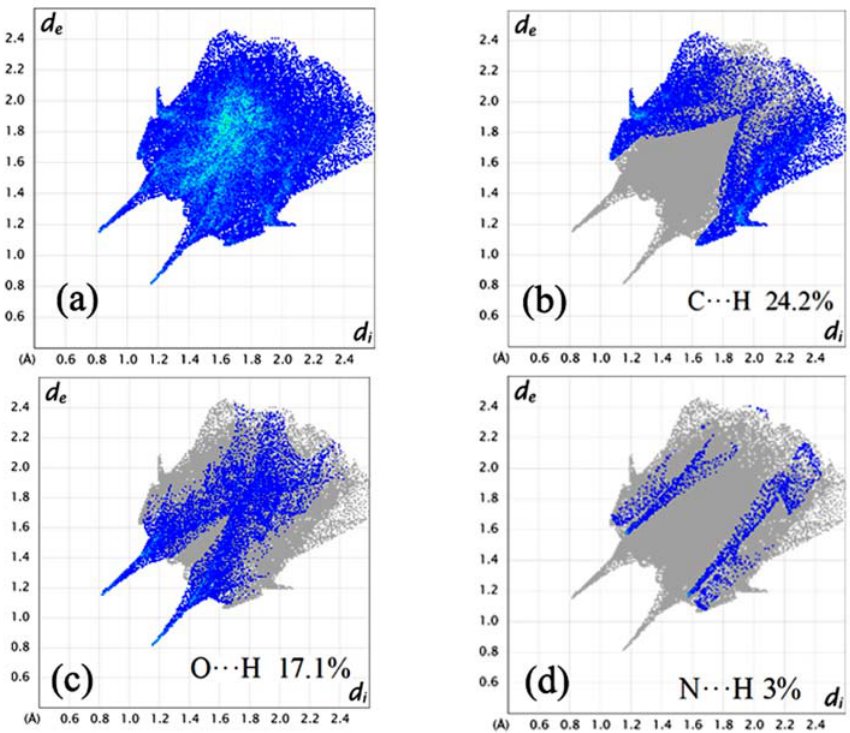
Fig. 11. 2D Finger print plot of experimental Form II with a) 100% contribution of all elements b) 24.2% of C···H/H···C interaction c) 17.1% O···H/H···O interaction d) 3% of N···H/H···N interaction.